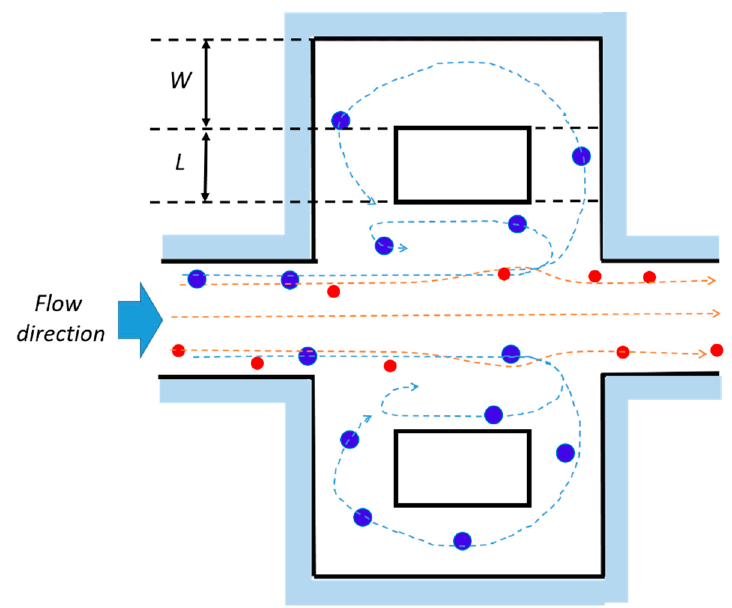
Figure 6. Schematic layout of the reservoir geometry tested by Paiè et al. [80]. Lateral channels of length L were added to the standard reservoirs [85] and joined together by a connection channel W wide. The dashed paths indicate the fluid streamlines followed by the big (blue) and small (red) particles. Adapted from [87].